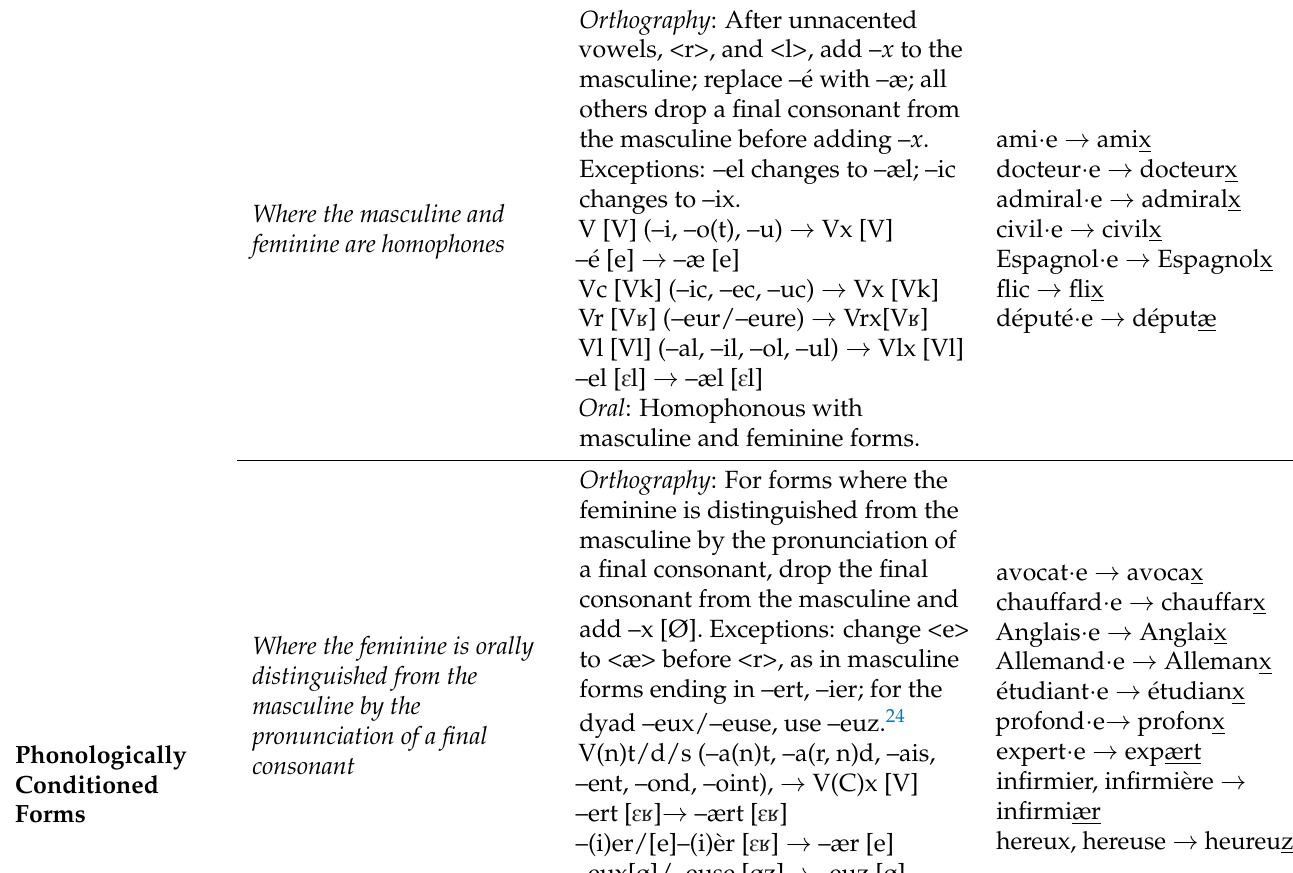
Table 4. Neutral Singular Nominal Endings in Alpheratz (2018).